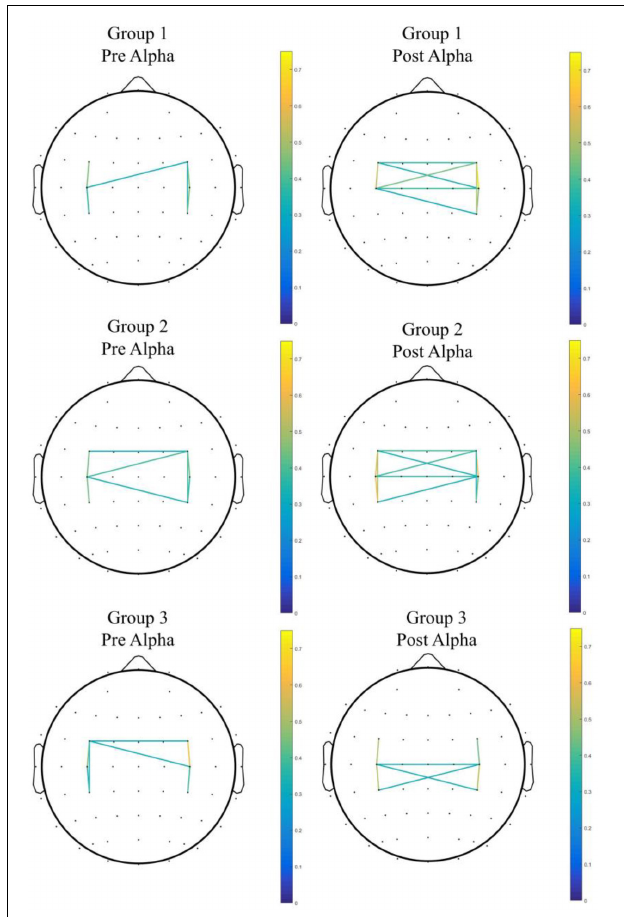
FIGURE 3 | The pre–post comparison of coherence in each group. Only pairs with coherence > 0.3 were